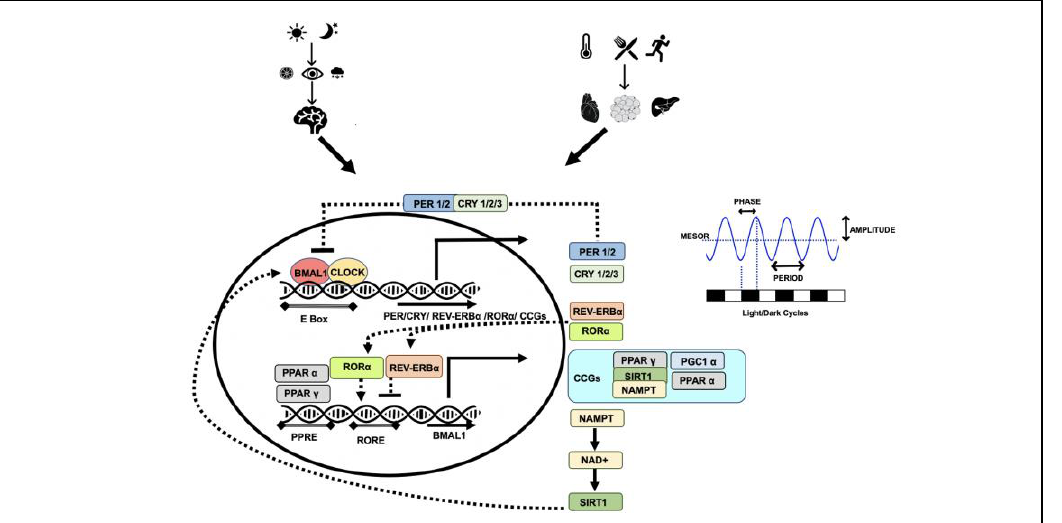
Figure 1. Circadian clock mechanisms: different zeitgebers lead to intricate transcription-translation feedback loop. circadian locomotor output cycles kaput (CLOCK) and brain and muscle Arnt-like protein-1 (BMAL1) heterodimerise and regulate the transcription of multiple clock-dependent genes (solid arrows). PER, CRY, REV- ERBα, RORα, PPARα, PPARγ, SIRT1 all lead to regulation of CLOCK and BMAL1 and contribute to their own regulation (dotted arrows). Amplitude, period, phase and MESOR of the oscillations produced determine the rhythmicity and robustness of the circadian clock. PER (Period), CRY (Cryptochrome), RORα (receptor - related orphan receptor α), REV- ERBα (NR1D1 gene producing a protein called REV - ERBα), PPARα (peroxisome prolife rator- activated receptor α), PPARγ (peroxisome proliferator - activated receptor γ), NAMPT (nicotinamide phosphoribosyltransferase), NAD + (nicotinamide adenine dinucleotide), AMPK (AMP-activated protein kinase), CCGs (clock-controlled genes), SIRT1 (sirtuin 1), PGC1 α (PPARγ coactivator 1α), MESOR (midline estimating statistic of rhythm).